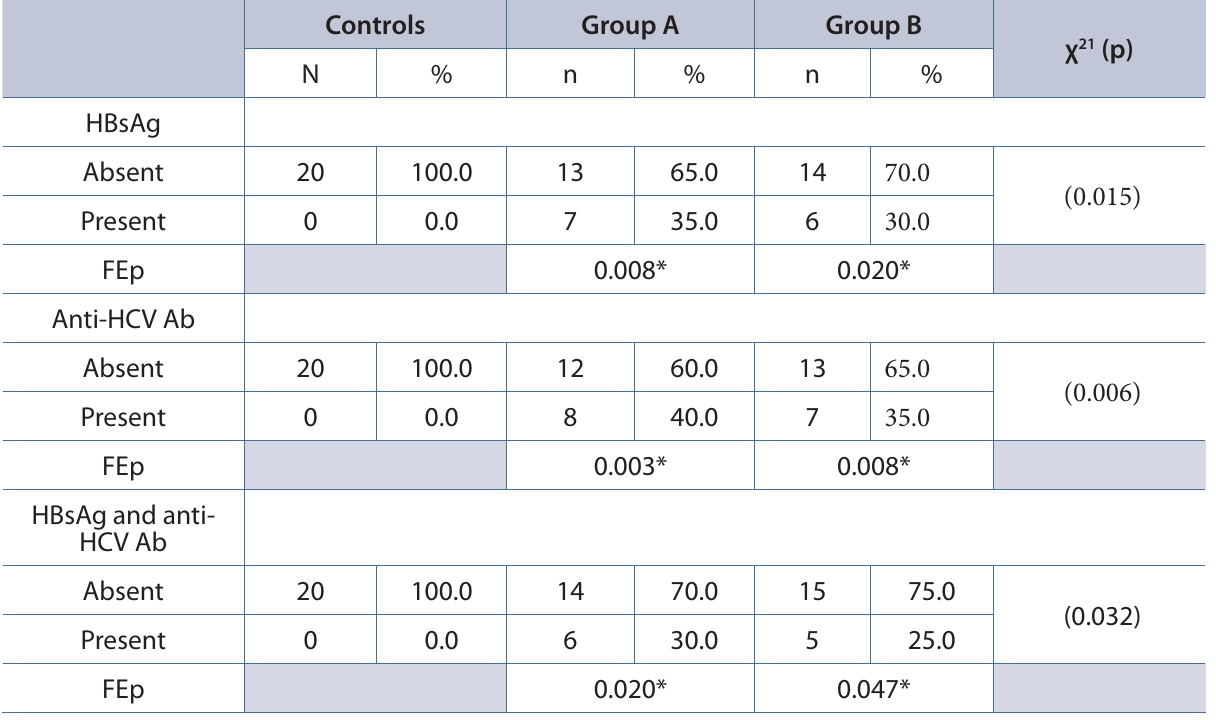
χ 21 : chi-square test between the different studied groups; FEp: p value for Fisher Exact test between control and other groups; *: statistically significant at p ≤